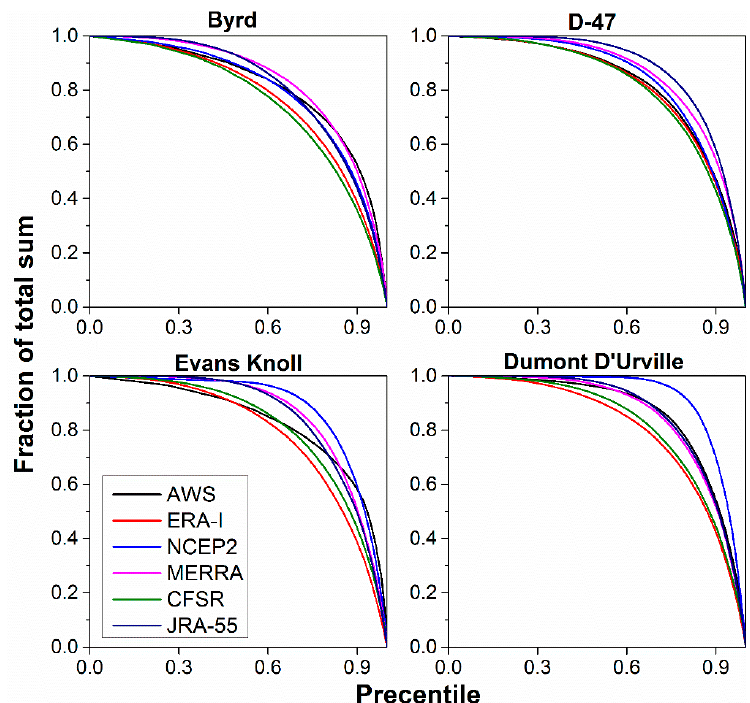
Figure 6. Distributions of the five reanalysis precipitation events and snow accumulation events for four stations. The x-axes show the precipitation/accumulation percentile, and the y-axes show the cumulated sum of all values above the respective percentile relative to the total sum.